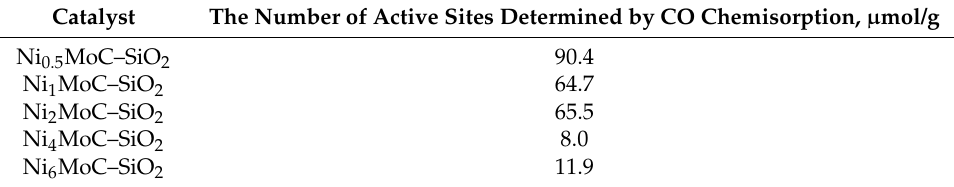
Table 5. The number of active sites in calcined and reduced Ni x MoC–SiO 2 (400/600) catalysts. Catalyst